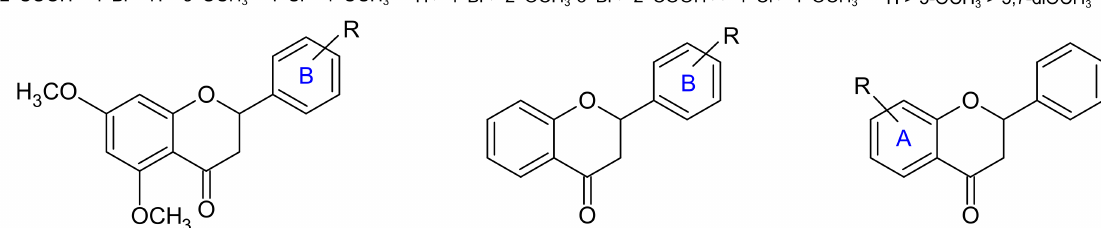
Figure 6. Correlations between structures and anti-inflammatory activity.